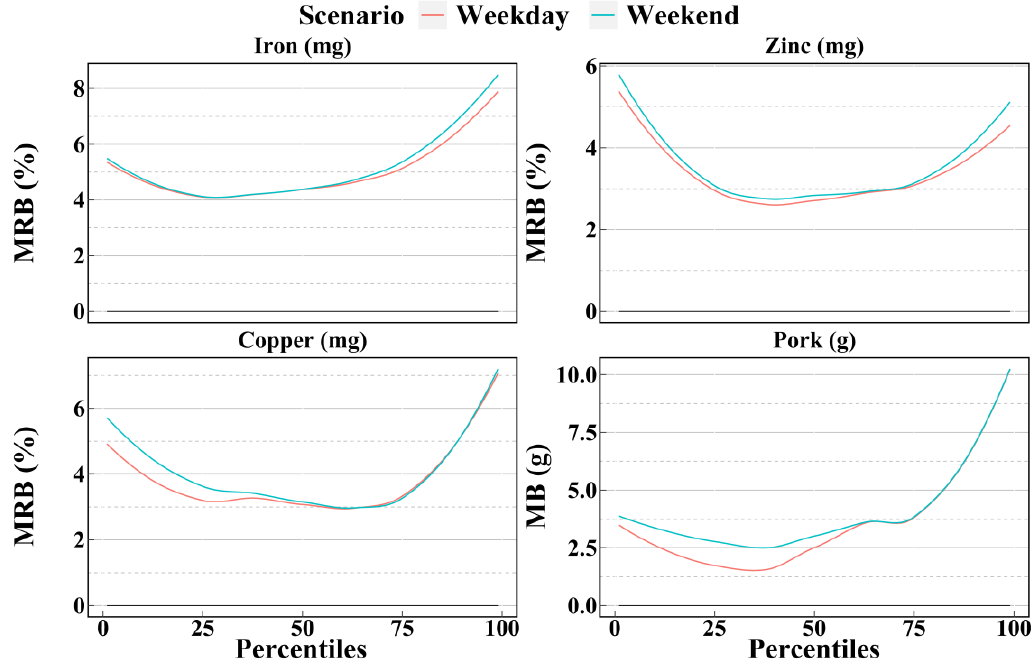
Figure 8. Smooth curves of the percentile (from 1st to 99th) intakes of dietary components in group 2 estimated by weekday and weekend of scenario NC2 based on the NCI method. Weekday = Two non-consecutive weekdays. Weekend = Of the two non-consecutive days, one was a weekend, and the other was a weekday; MRB = Mean relative bias; MB = Mean